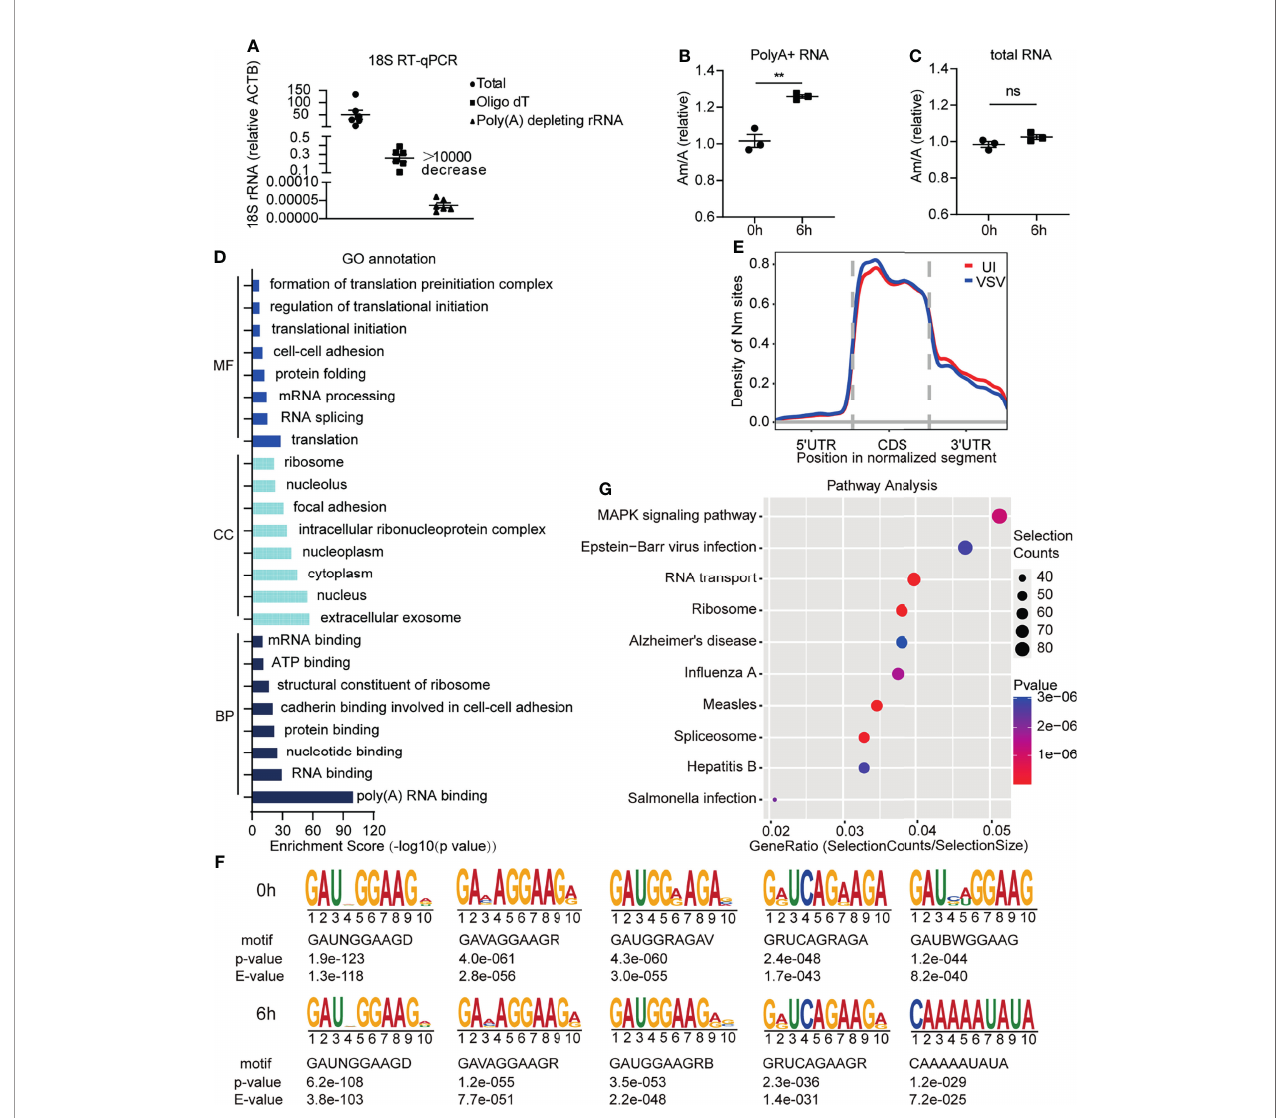
FIGURE 1 | Increased Am modi fi cation on poly A+ RNA in macrophages upon viral infection. (A) Determination of poly A+ RNA purity through RT-qPCR with primers speci fi c to 18S rRNA and Actb . Total, total RNA; Oligo dT, poly A+ puri fi ed by Oligo dT beads; Poly A+ depleting rRNA, poly A+ puri fi ed by Oligo dT beads and rRNA depleting kit (n=6); (B) Quanti fi cation of the Am/A ratio in poly A+ RNA of RAW264.7 cells with or without VSV infection (n=3). 0h, RNA from RAW264.7 cells; 6h, RNA from RAW264.7 cells infected with VSV (MOI=1) for 6 h; (C) Quanti fi cation of the Am/A ratio in total RNA of RAW264.7 cells with or without VSV infection (n=3). 0h, RNA from RAW264.7 cells; 6h, RNA from RAW264.7 cells infected with VSV (MOI=1) for 6 h; (D) GO terms of MF, CC, BP for Nm-methylated transcripts of RAW264.7 at the steady state; MF, Molecular function; CC, Cell Compartment; BP, Biological process; (E) Metagene pro fi le of Nm sites distribution along a normalized mRNA transcript; (F) Sequence logo of enriched motifs behind Nm sites identi fi ed by HOMER; (G) KEGG pathway enrichment for Nm up- regulated genes after viral infection. UI, poly A+ RNA from RAW264.7 cells; VSV, poly A+ RNA from RAW264.7 cells infected with VSV (MOI=1) for 6 h. All data are mean ± SEM of biologically independent samples.ns, not signi fi cant, ** P < 0.01, two-tailed unpaired Student ’ s t